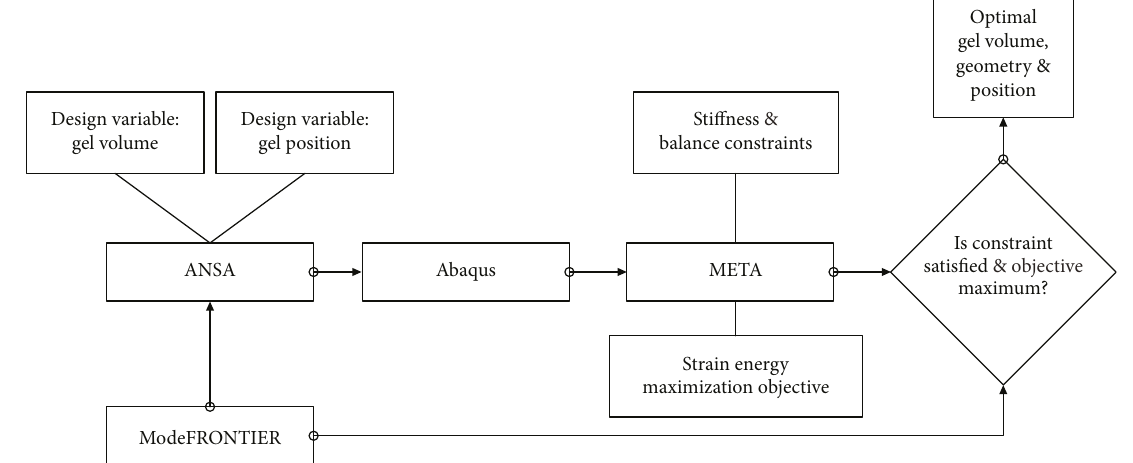
Figure 4: Logical diagram of the optimization setup. As shown in the logic diagram, both the in fl uence of the position and volume of the gel pads were considered design parameters of the same loop and thus optimized in a single setup of the function/model.